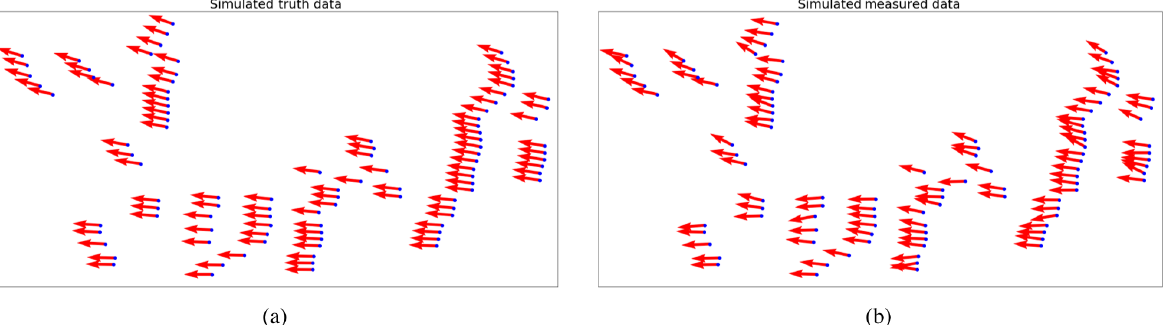
Figure 3. (a) This plot shows the simulated “truth” data underlying wind direction data based on the 30 ◦ wind direction change across the wind farm. (b) This plot shows the simulated “measured” wind direction with noise added on top of the “truth” data. Note that the arrows are pointed in the upwind direction.